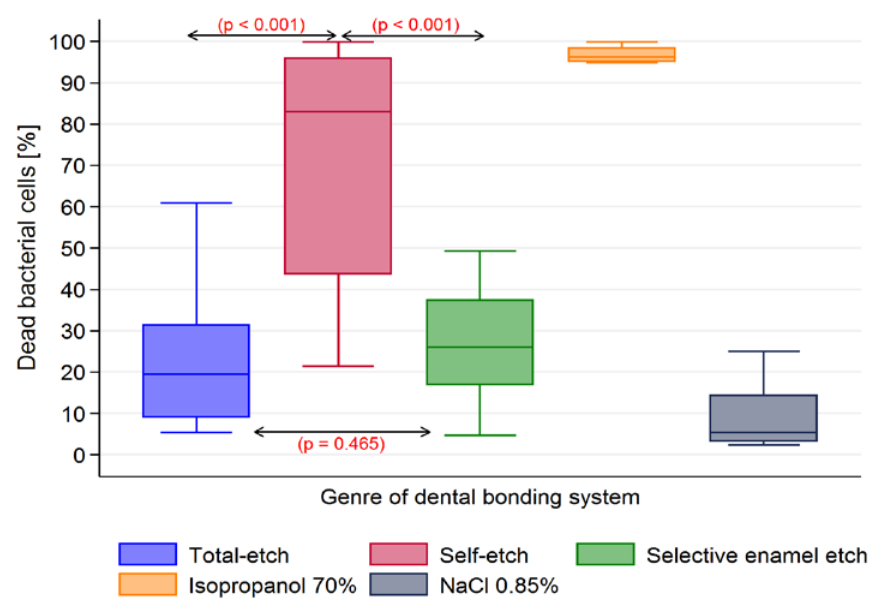
Figure 5. Assessment of dead bacterial cells [%] after incubation–group comparison of types (TE, SE, SEE) of tested DBS.